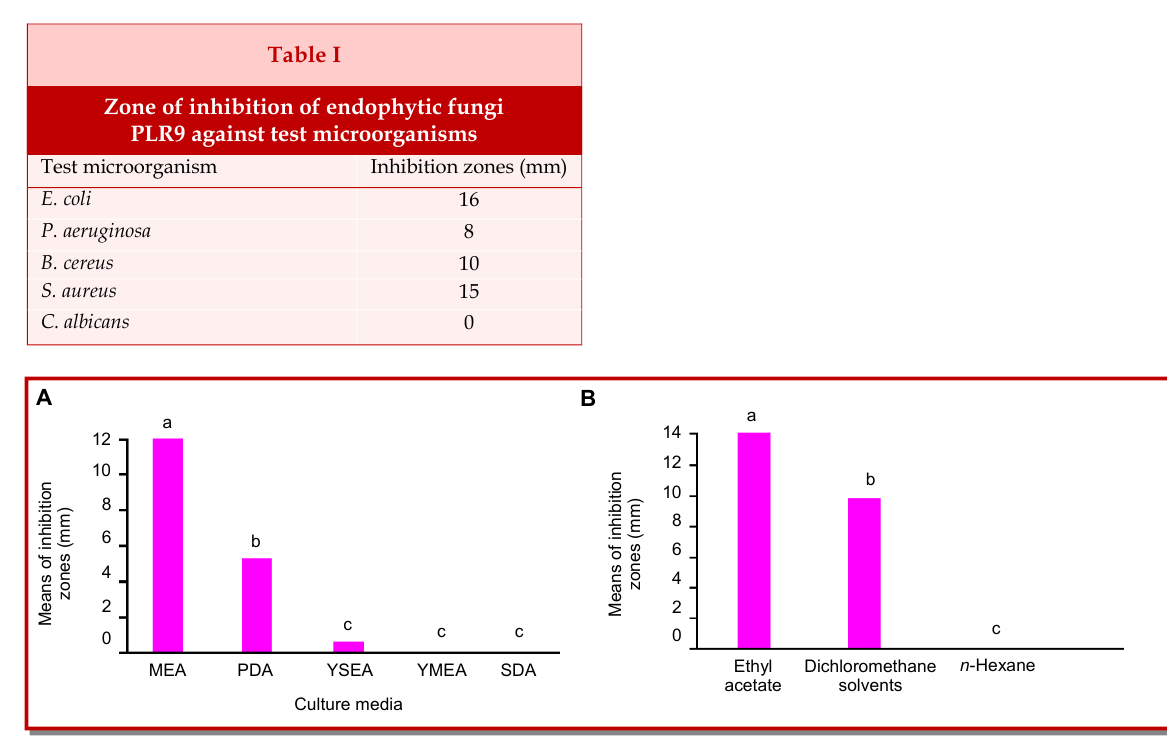
Figure 3: Effect of culture media (A) and solvent used (B) on antibacterial activity of PLR9 isolate, means with the same letter are not significantly different at (p<0.05); MEA (malt extract agar), PDA (potato dextrose agar ), YSEA (Yeast extract sucrose agar), YMEA (yeast extract malt extract agar), SDA (Sabouraud dextrose agar); superscript “a, b, c” means with the same letter are n ot significantly different at